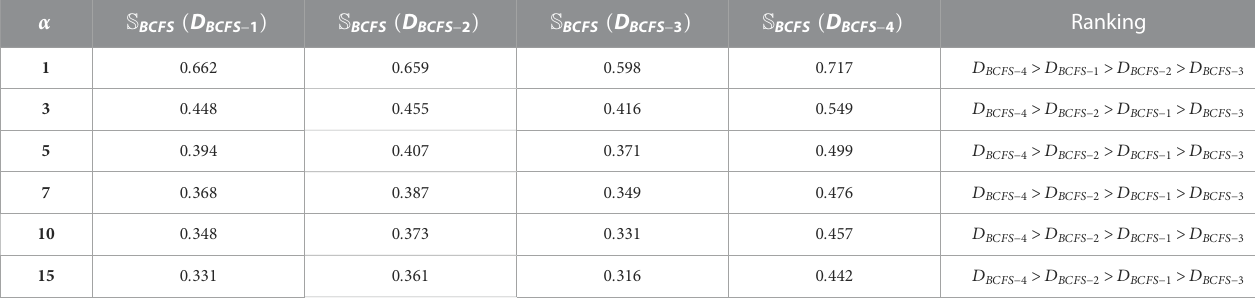
TABLE 12 Score values and ranking order for various values of α using the BCFPDOWA operator. α